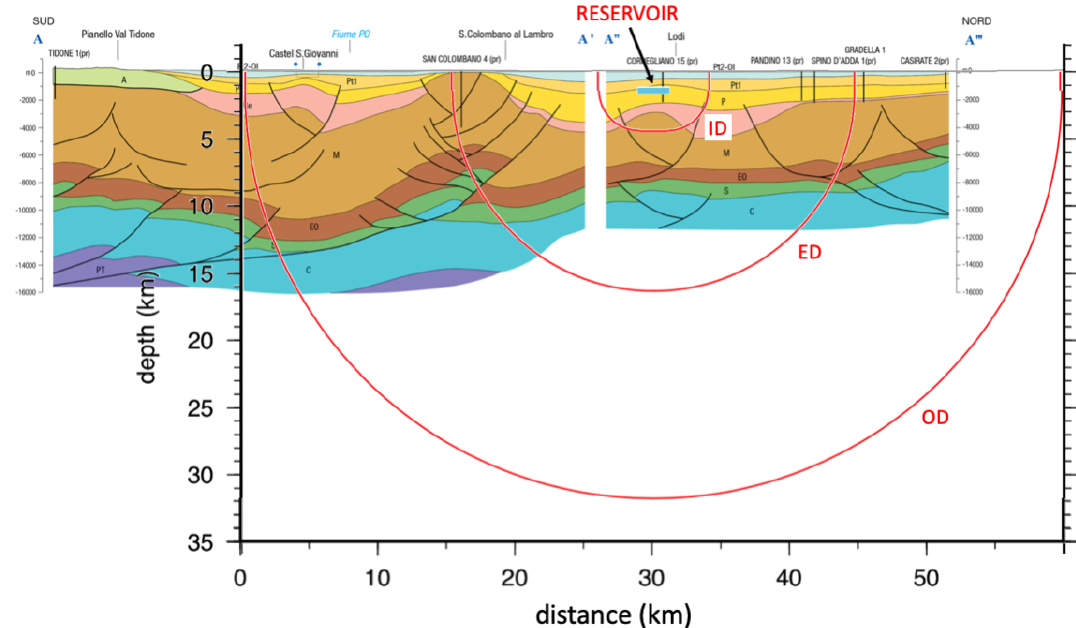
Figure 2. Geological NNE–SSW cross sections in the Po Plain, modified after Martelli et al. (2016). The contour lines of the monitoring domains are represented by red circles. ID: inner domain; ED: extended domain; OD: outer domain. Light blue segment: UGS reservoir of Cornegliano Laudense. See text for more